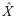
Schematics of L–point windows and reconstructed phase spaces.(a) Two time–series x(t) and y(t) and a schematic of the L–point windows with different lengths sweeping the whole span of the time–series. (b) A schematic of the reconstructed phase spaces of the L–point windows corresponding to two time–series. For each E-dimensional Y–central point, Y
c, in the response reconstructed phase space, M
y, a sufficient number of nearest neighbor points are selected (empty circles, Y
j, right) and their distances, d
j, to Y
c are determined. For each neighbor point, its contemporaneous point in the driver reconstructed phase space, M
x, is determined (empty circles, X
j, left). The weighted average of these points, X^, is compared with X
c, the true contemporaneous point in M
x corresponding to Y
c. The CCM coefficient, ρ(L), is defined as the correlation coefficient between X^ and X
c, averaged over all possible L–point windows.